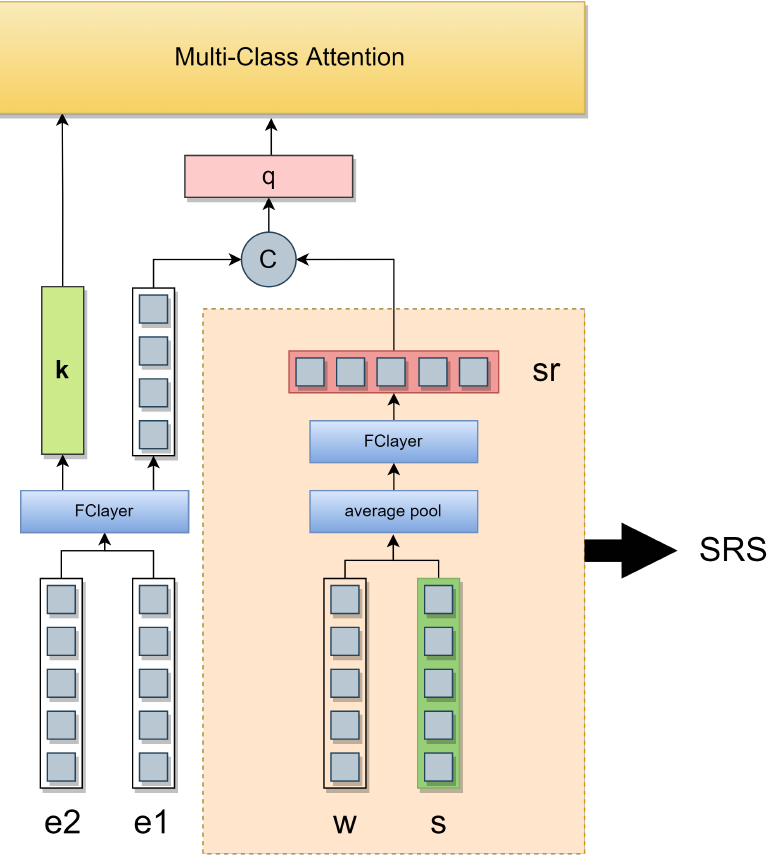
Figure 3. This is the internal detail diagram of the prediction structure. When the entity and s are fed into the prediction structure, they will be divided into two ways, one way to construct the keys needed for Multi-Class Attention and one way to construct the queries needed for Multi- Class Attention. SRS is the process of averaging the w representing the global semantics and the s representing the local semantics, and then feeding them into the fully connected